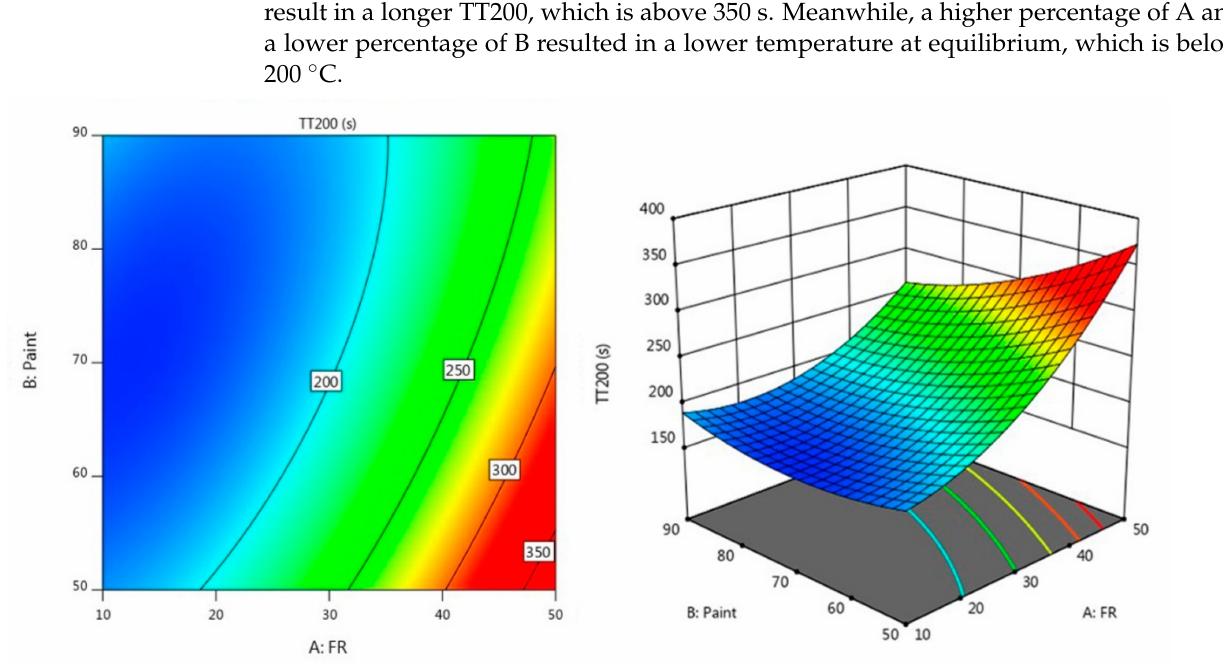
Figure 3. Contour plot for the effect of FR and paint on TT200 in the fire resistance test.